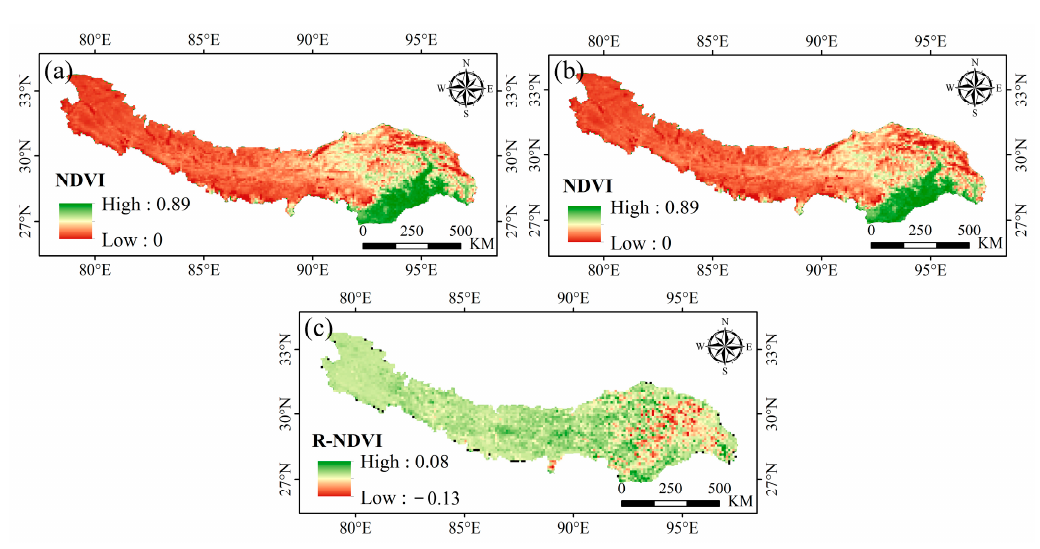
Figure 7. The spatial patterns of the average growing-season NDVI in 1982 ( a ) and 1987 ( b ) as well as the di ff erence between them ( c ).